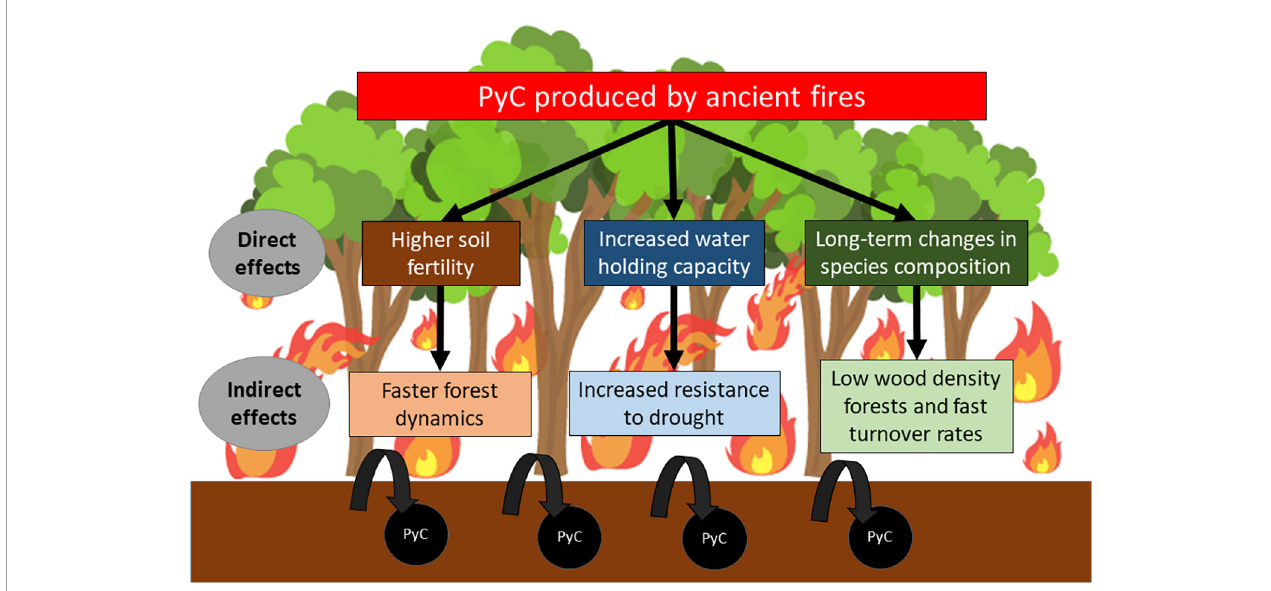
FIGURE1 Potential pathways by which ancient fires may influence forest responses to drought.